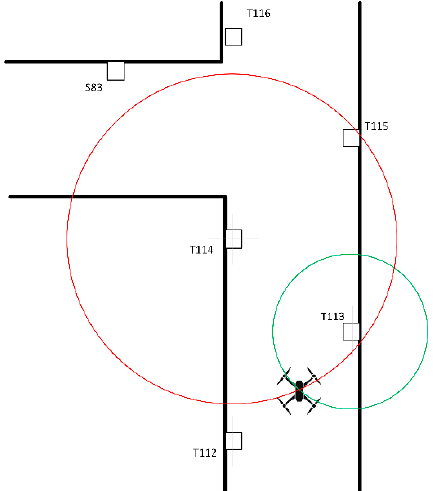
Figure 4. Using bilateration from well-known position tags to find out UAV’s positioning with a certain degree of cross-track and along-track errors.